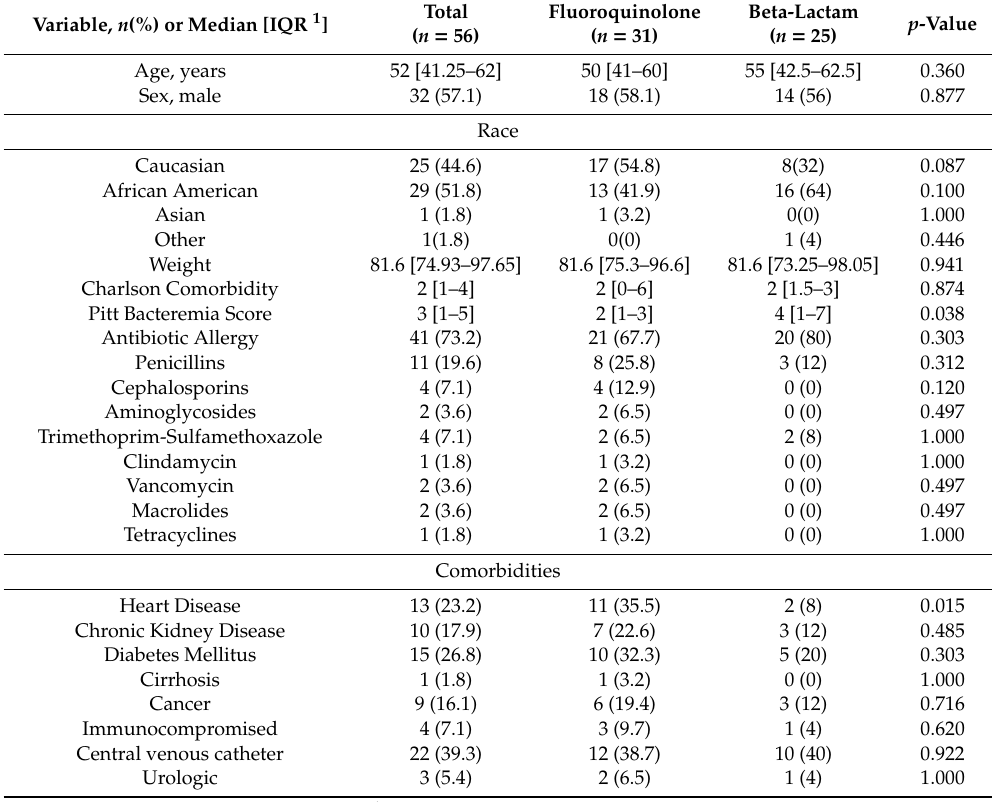
Table 1. Baseline Demographics of Patients Receiving Fluoroquinolone versus Beta-Lactam Definitive Therapy for Chromosomally mediated AmpC-producing Enterobacteriaceae (CAE) Bloodstream Infections.